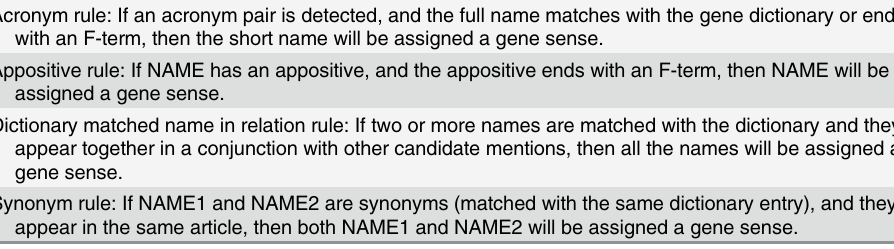
Table 5. Rules for disambiguation of name as gene or non-gene. Acronym rule: If an acronym pair is detected, and the full name matches with the gene dictionary or ends with an F-term, then the short name will be assigned a gene sense. Appositive rule: If NAME has an appositive, and the appositive ends with an F-term, then NAME will be assigned a gene sense. Dictionary matched name in relation rule: If two or more names are matched with the dictionary and they appear together in a conjunction with other candidate mentions, then all the names will be assigned a gene